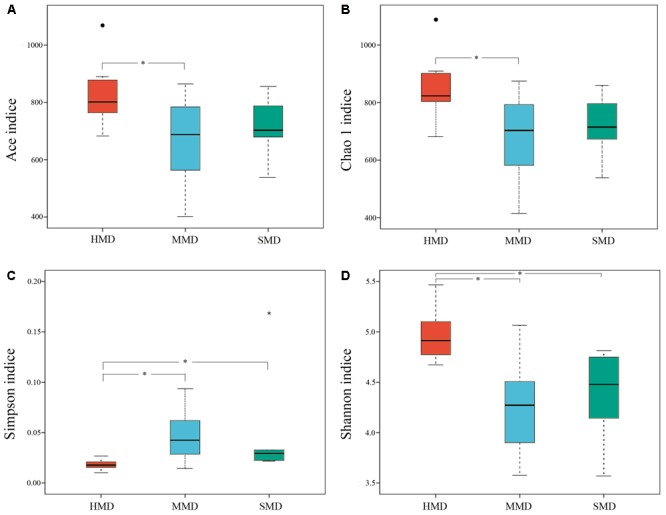
Boxplot of Alpha-diversity indices. Alpha diversity indexes are composite indexes reflecting abundance and consistency. (A) Ace and (B) Chao1 indices reflect the OTU abundance in samples. (C) Shannon and (D) Simpson indices reflect the diversity of OTU in samples. The greater the Chao or ACE index, the higher the expected species richness of the microbiota; the smaller the Simpson index, the higher the diversity of the microbiota, and the greater the Shannon index, the higher the diversity of the microbiota. Boxes represent the interquartile range (IQR) between the first and third quartiles (25th and 75th percentiles, respectively), and the horizontal line inside the box defines the median. Whiskers represent the lowest and highest values within 1.5 times the IQR from the first and third quartiles, respectively. “∙” Indicates greater than 1.5 times and less than three times the IQR; “∗”indicates greater than three times the IQR; ∗P < 0.05 (Student’s t-test).